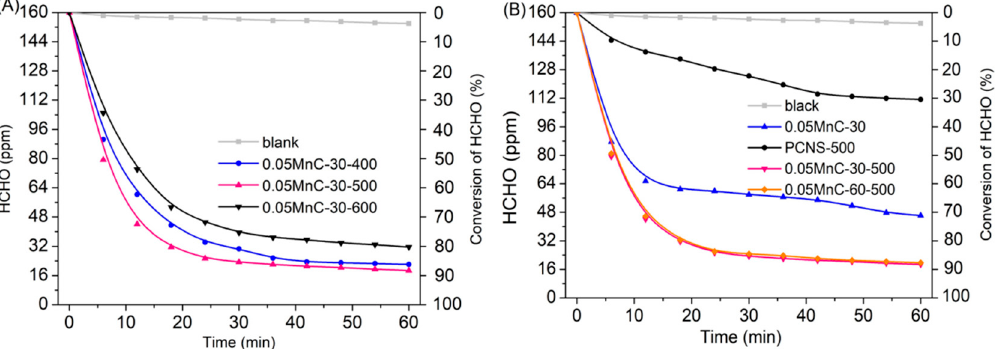
Figure 2. ( A ) The HCHO elimination rate under xenon light irradiation by Mn − PCNS catalysts under processing temperatures. ( B ) The HCHO elimination rate under xenon light irradiation by 0.05MnC-30, PCNS-500, 0.05MnC-30-500, and 0.05MnC-60-500 catalysts.